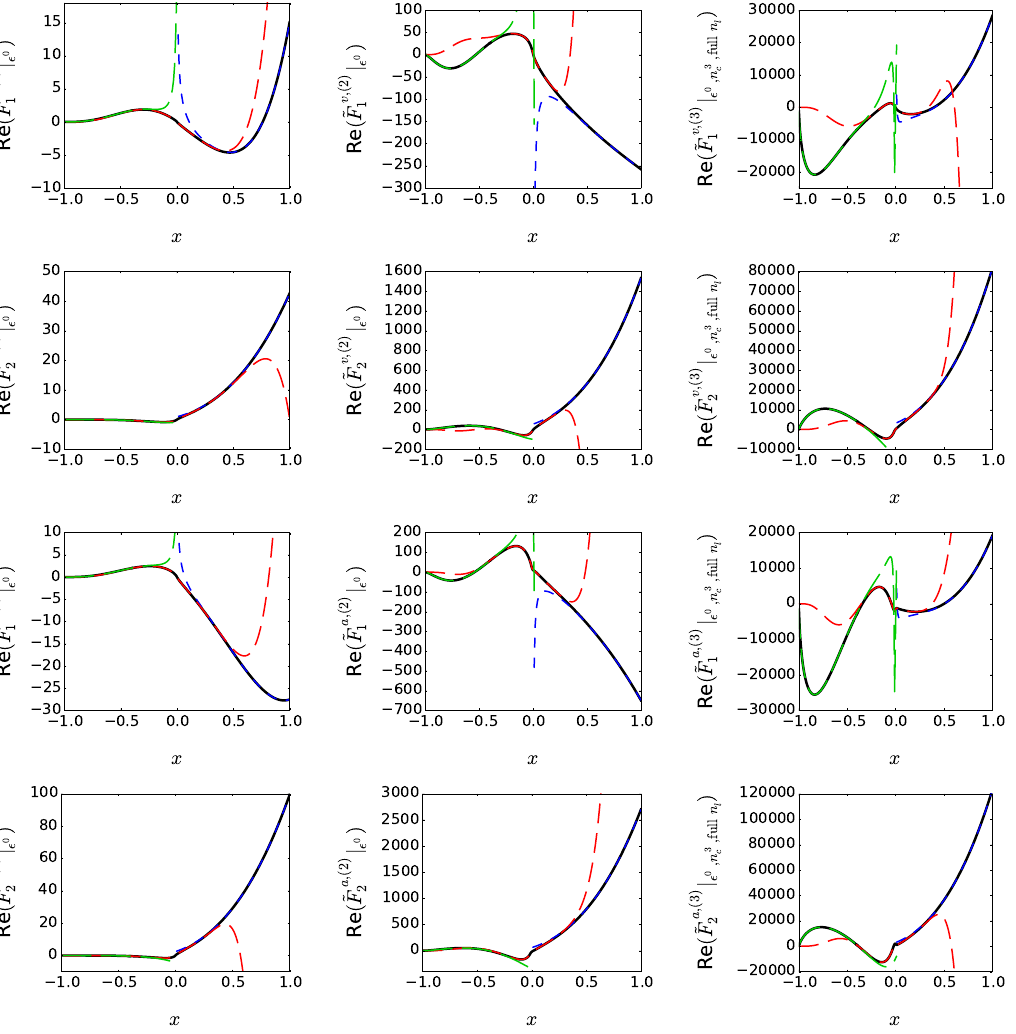
Figure 3 . Real part of the ǫ 0 term of the vector and axial-vector form factors as a function of x . Exact results and approximations are shown as solid and dashed lines, respectively. At three- loop order we add the complete light-fermion part for n l = 5 and the N 3 c contribution. Short- (blue), medium- (red) and long- (green) dashed lines correspond to the low-energy, high-energy and threshold approximation,